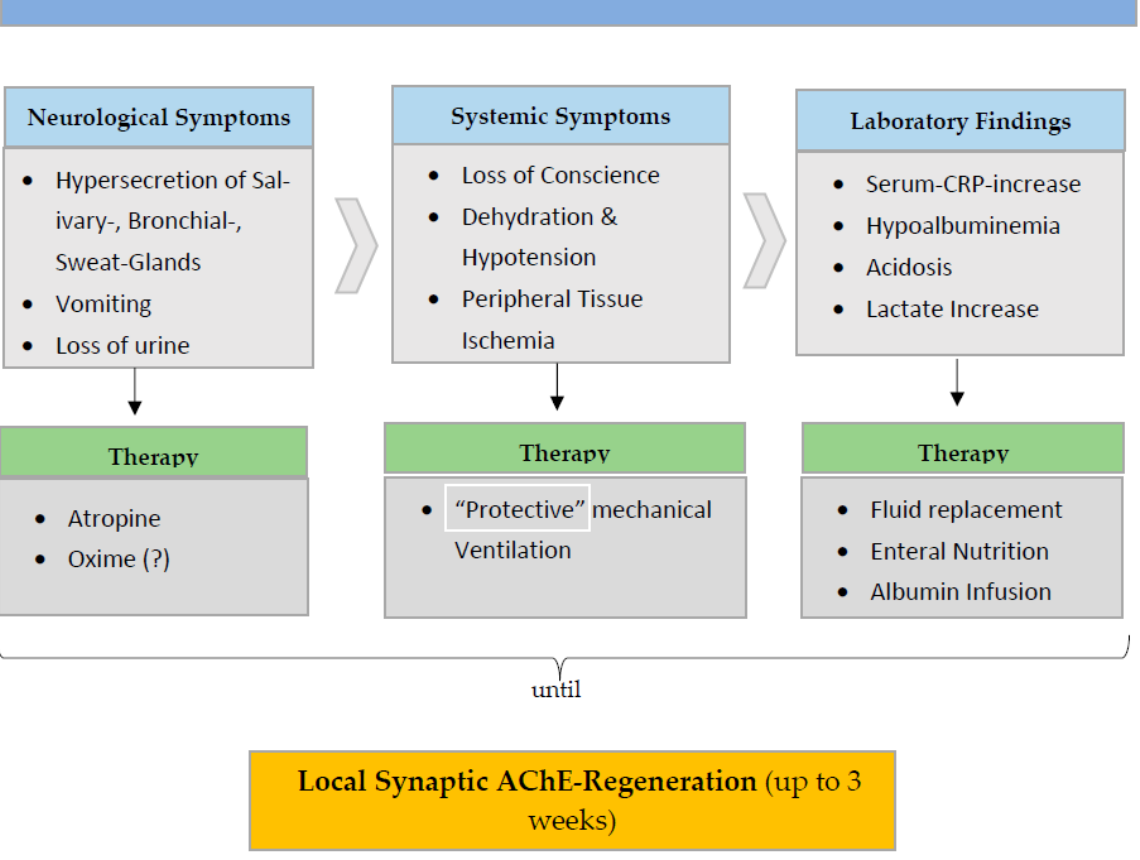
Figure 1. Main clinical and laboratory findings and therapeutic consequences in hospitalized patients after organophosphate poisoning. Production of sufficient “new” AChE at the level of the neuronal synapses can take up to 3 weeks.